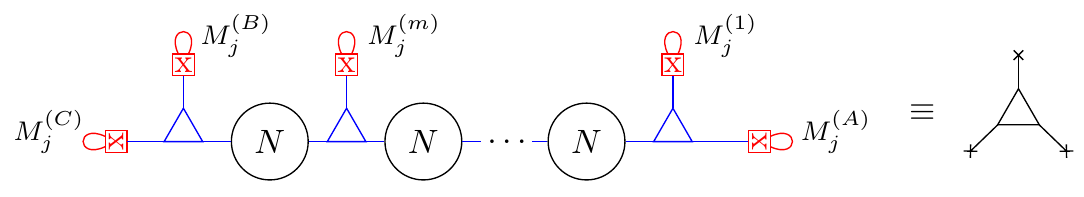
Figure 4. UV quiver for the T ( m ) theory with (cid:27) i = +1, Higgsing the SU( N ) (cid:13)avor nodes. The N rightmost (cid:12)gure depicts a shorthand we use throughout, for